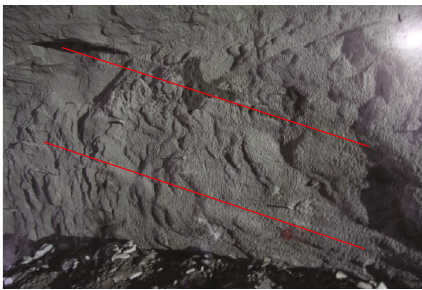
Figure 26: Wedge failure of side wall and arch shoulder in K0 +10m of the main transformer room downstream.